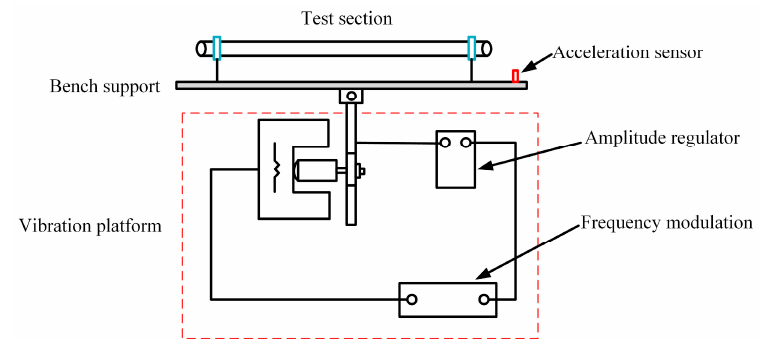
Figure 2. Vibration device. Table 1. Vibration frequency and amplitude selection under transverse